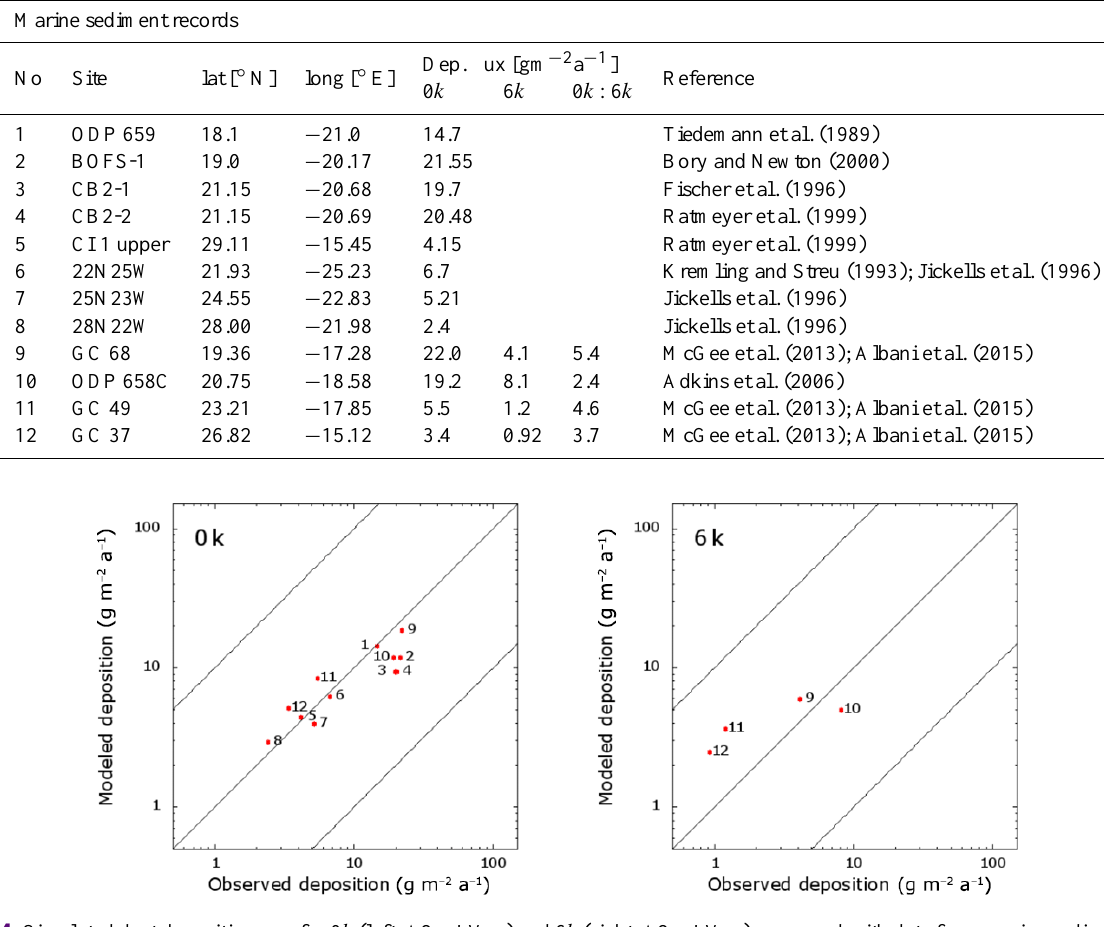
Figure 4. Simulated dust deposition flux for 0 k (left, AO 0 k LV 0 k ) and 6 k (right, AO 6 k LV 6 k ) compared with data from marine sediment cores and sediment traps (Table 4). Log correlation coefficients are 0.89 (0 k ) and 0.85 (6 k ).